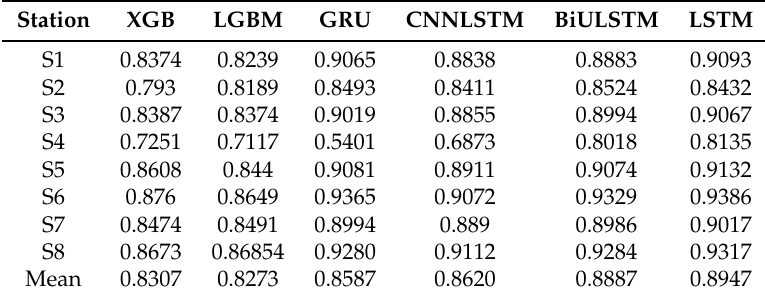
Table A3. Models results for R .